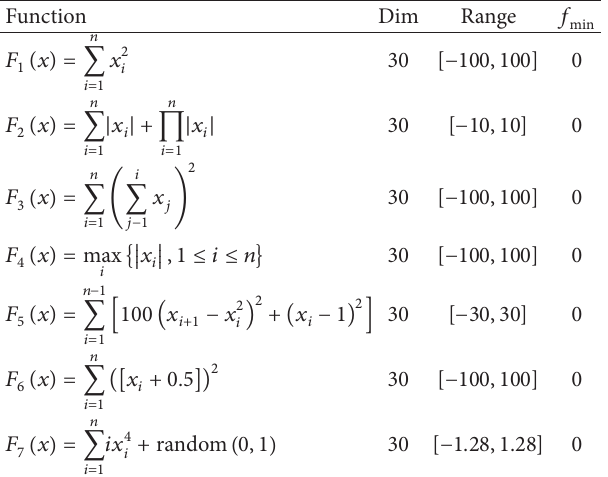
Table 1: Unimodal benchmark